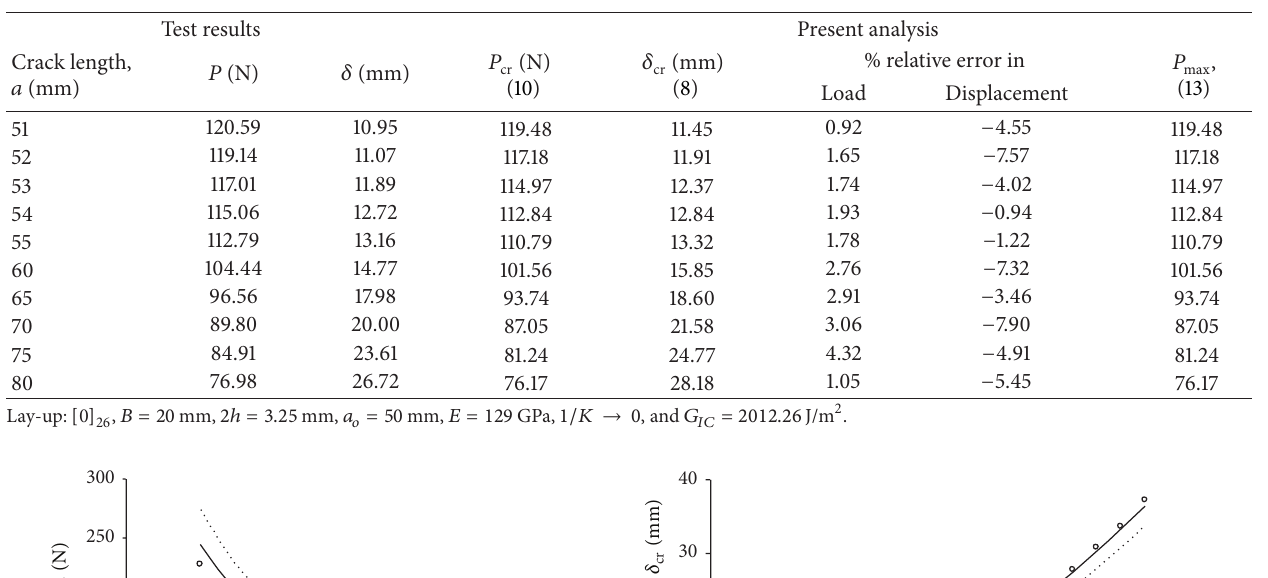
Table 3: Critical load 𝑃 and corresponding displacement 𝛿 cr carbon/PEEK composite.